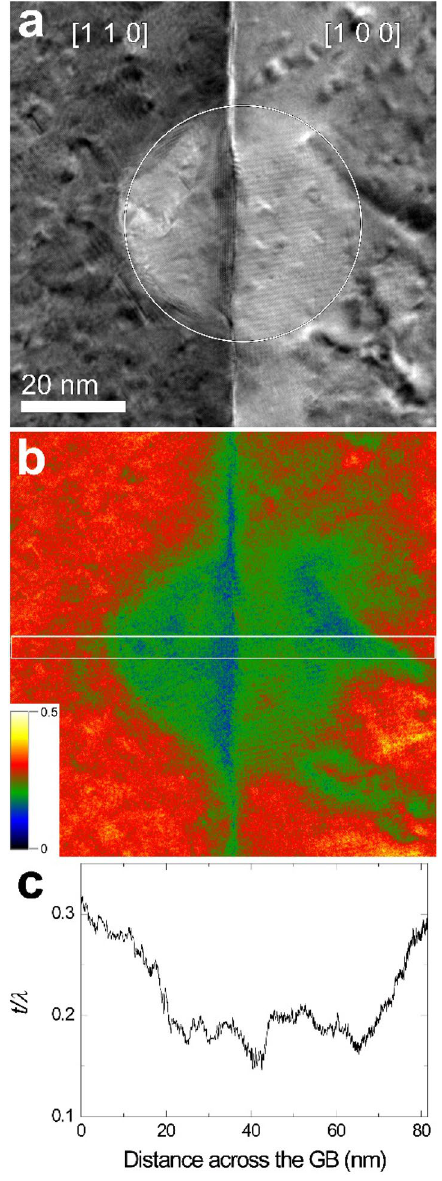
Figure 5. ( a ) EFTEM image (unfiltered) obtained from a beam irradiated area at 50 nm for 3 min 20 s and ( b ) a corresponding thickness map. ( c ) Line profile of relative thickness for the rectangular area shown in ( b